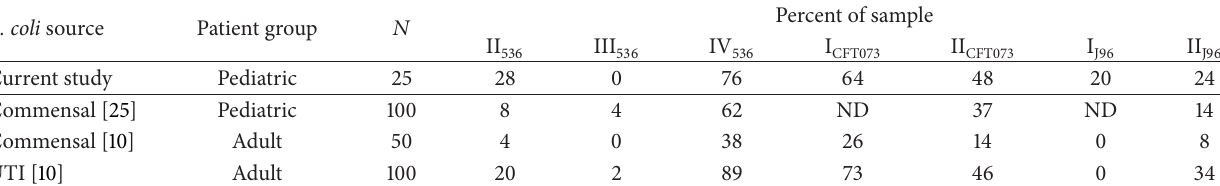
Table 2: Pathogenicity islands (PAIs) present in E. coli strains.